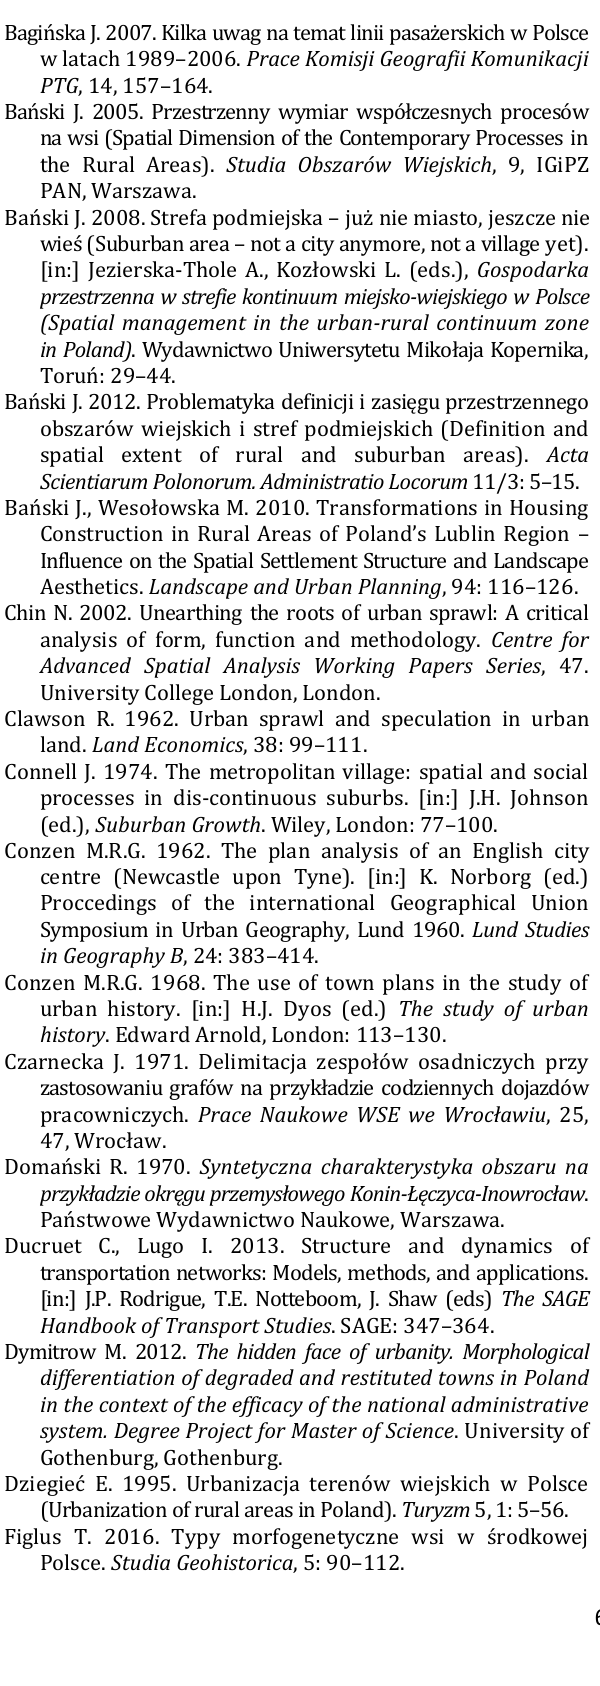
Figlus T. 2018. The past and present of historical morphology of rural and urban forms in Poland. Studia Geohistorica , 6: 149–168. Figlus T. 2020. Process of incorporation and